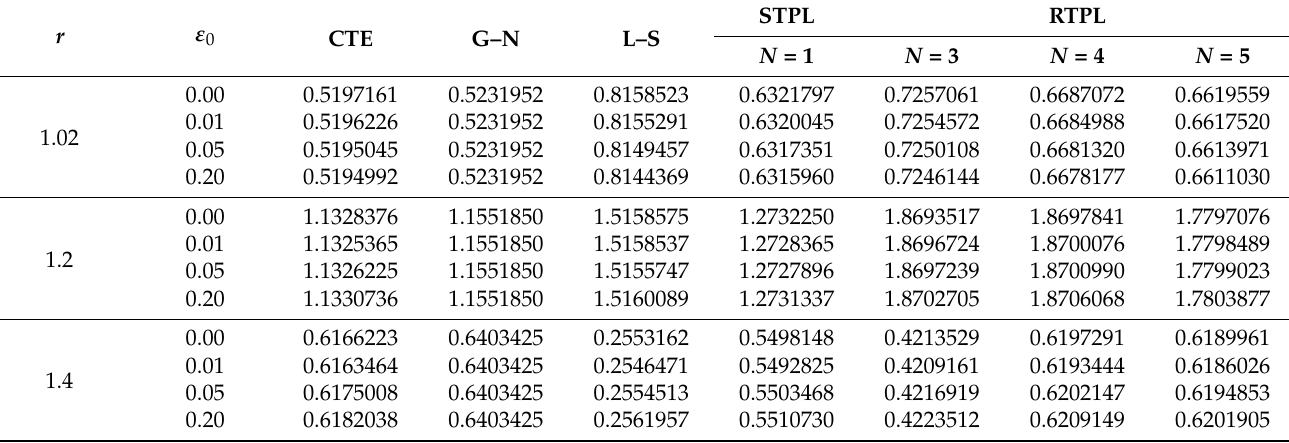
Table 13. Different thermoelasticity theories with a range of r values show the effects of dimensionless electric permittivity ε 0 on temperature Θ